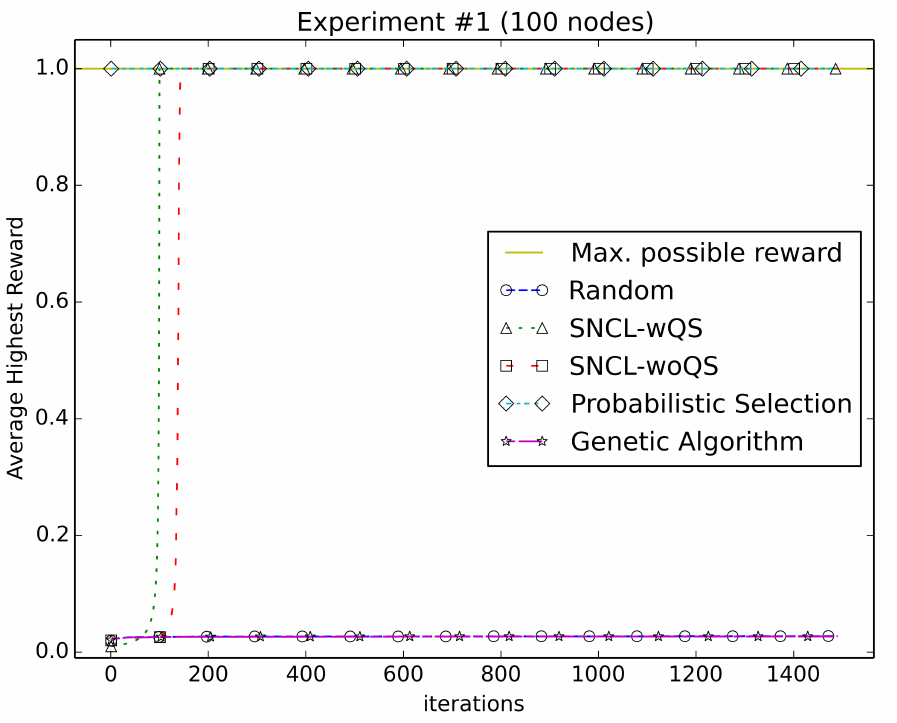
Figure 3. Using reward Equation (1). SNCL-woQS, sensor network configuration learning without quick